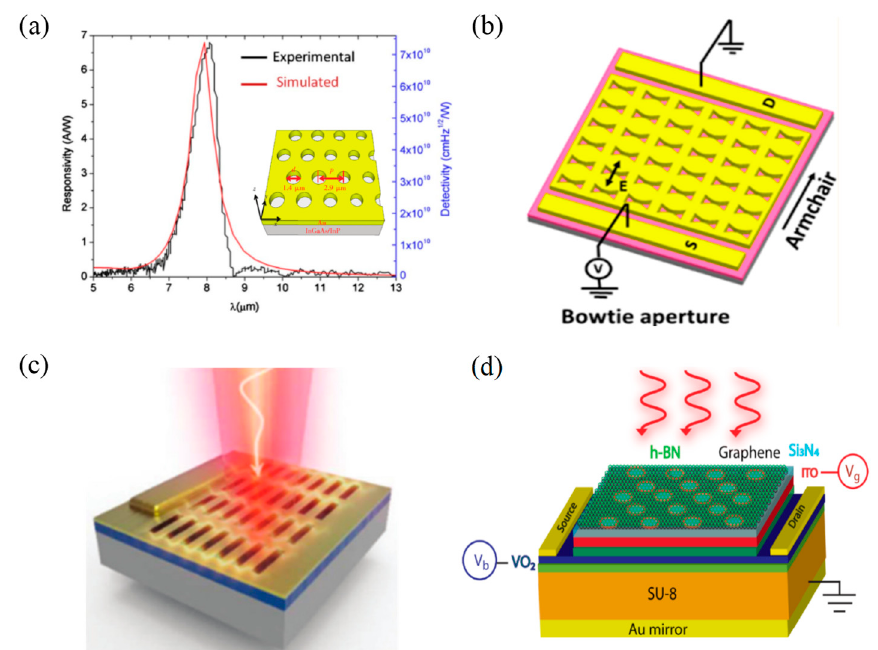
Figure 3. Structures and performance characterization of 2D materials-based infrared PDs with hole array structures. ( a ) Schematic diagram of the device’s responsivity and detectivity. The inset shows a schematic of the structure of the device with an array of metal vias [34]. Copyright 2010, Applied Physics Letters . ( b ) Schematic diagram of the BP device with the bowtie hole array [35]. Copyright 2018, ACS Nano. ( c ) Polarization structure of the nanohole array [36]. Copyright 2020, Nanoscale . ( d ) Schematic diagram of the proposed mid-infrared PD based on IMT [37]. Copyright 2021, ACS Ap-